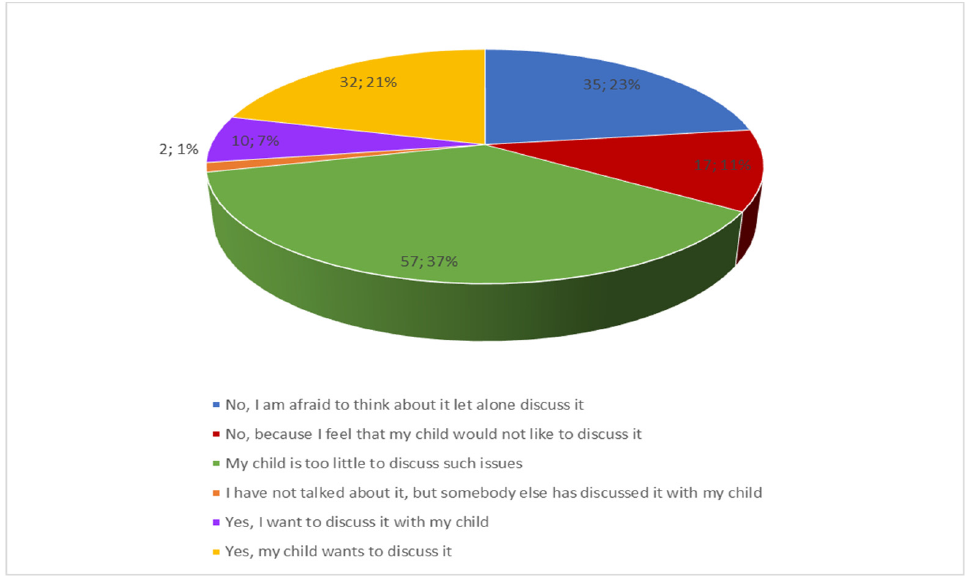
Figure 5. Distribution of responses to the question about conversations with the child about death and dying.